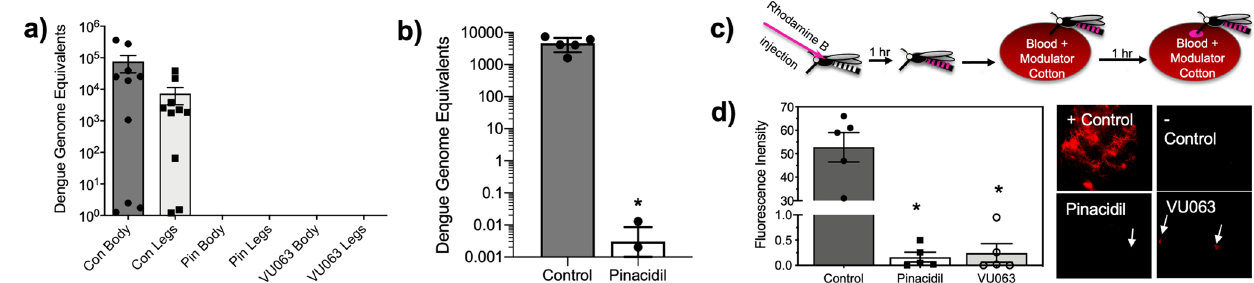
Fig. 5 In fl uence of K ATP activators on the horizontal transmission of DENV2 and a model pathogen from Aedes aegypti . a DENV2 genome equivalents from bodies and legs of individual mosquitoes 18 days post-feeding on control, pinacidil-, or VU0071063 treated blood meals positive for DENV2. Bars represent mean ( n = 10, 100 individuals per replicate) and error bars represent SD. b DENV2 genome equivalents from blood meals fed on by DENV2- infected mosquitoes. Bars represent mean ( n = 5) and error bars represent SD. Asterisk represents statistical signi fi cance at P < 0.0001 as determined by an unpaired t -test. c Experimental design of horizontal transmission of a model pathogen from A. aegypti . d Fluorescence units from blood-soaked cotton balls treated with vehicle control, pinacidil (700 µ M), or VU0071063 (300 µ M) that were fed upon by mosquitoes inoculated with rhodamine B, which was used as a model pathogen. Bars represent mean ( n = 5) fl uorescence units and error bars represent SEM. Note the change in scale of the Y-axis. Asterisks represent statistical signi fi cance at P < 0.0001 as determined by an unpaired students t -test. Representative fl uorescent images of control, pinacidil, and